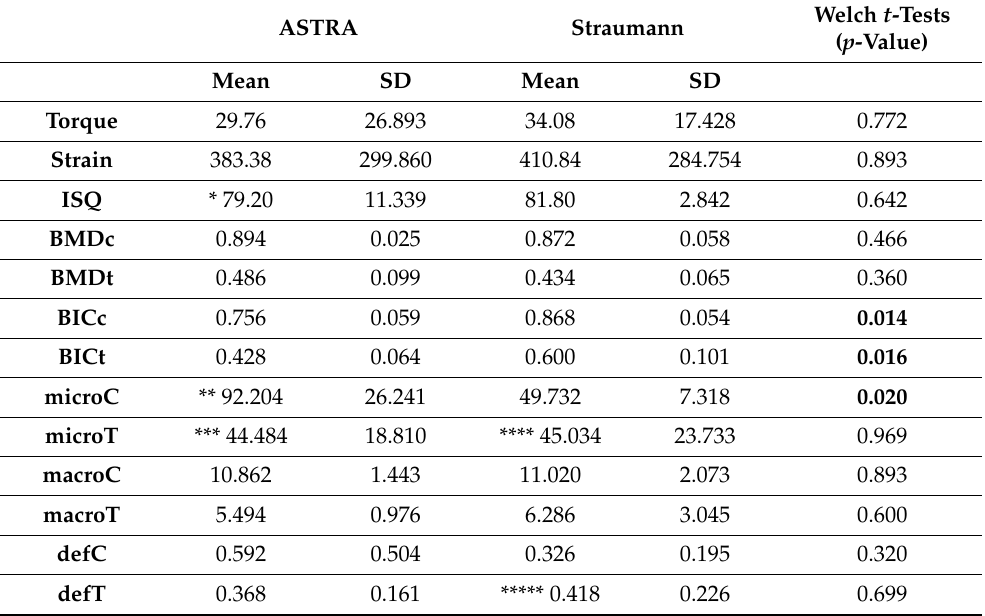
Welch t -Tests ( p -Value)